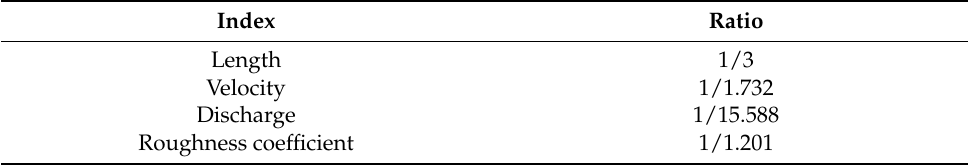
Table 1. Ratio between real scale and experimental